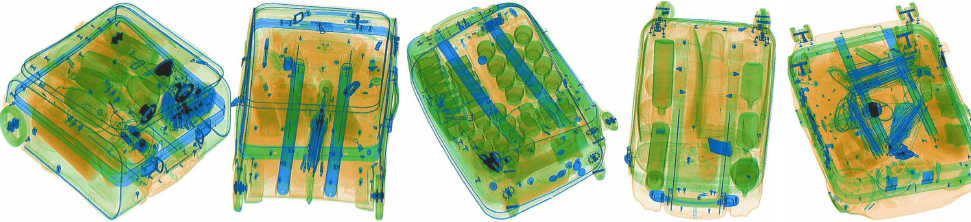
Figure 2. False-negative images from the SIXray dataset [17]. The red bounding boxes that are newly annotated by SIXray-D indicate the contraband items from the classes Knife and Scissors.